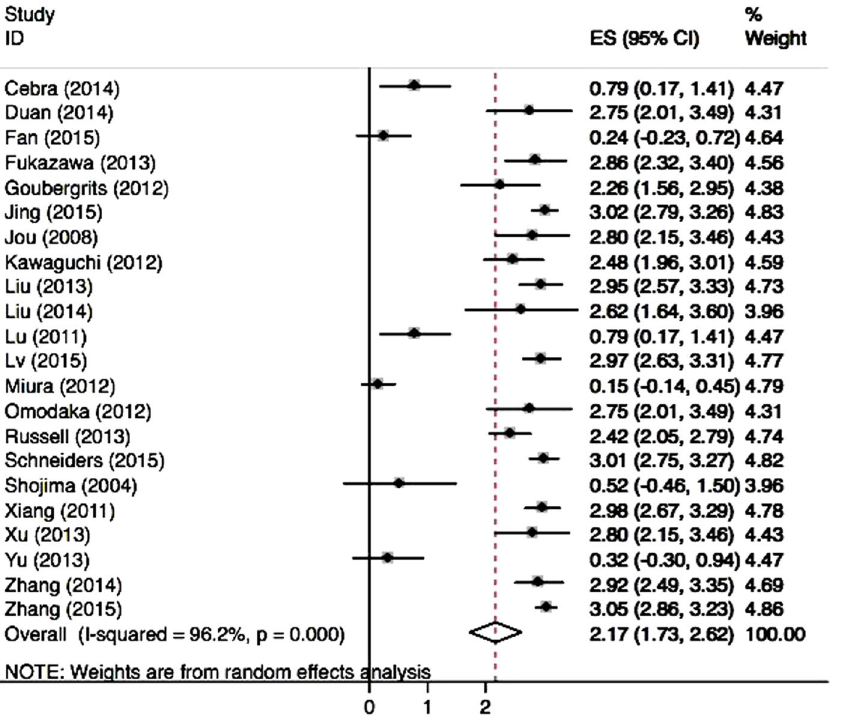
Figure 1. Meta-analysis of the reported low WSS rate of ruptured